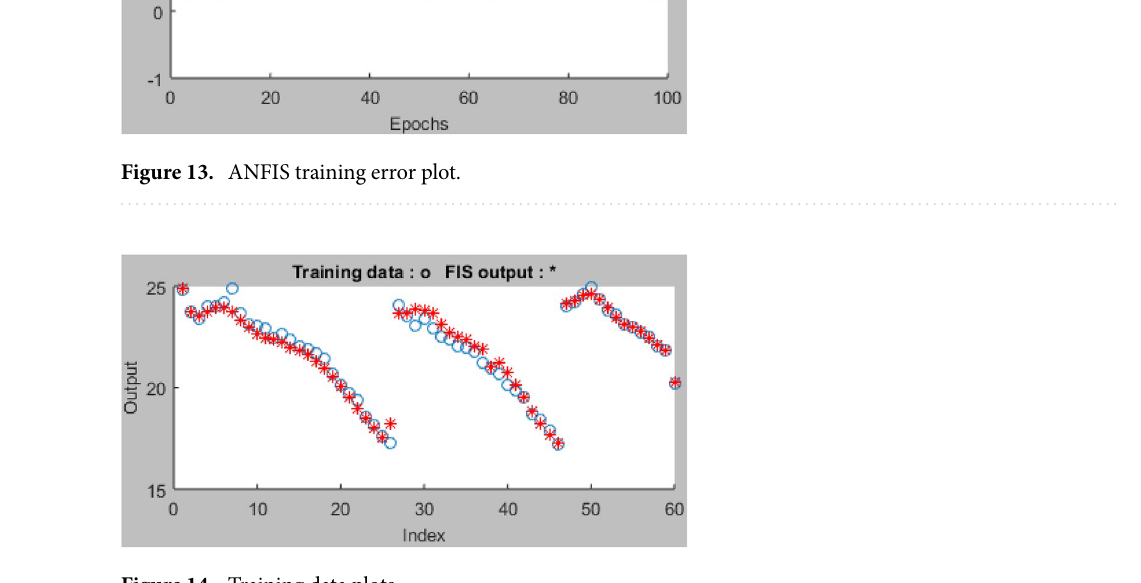
Figure 14. Training data plots.